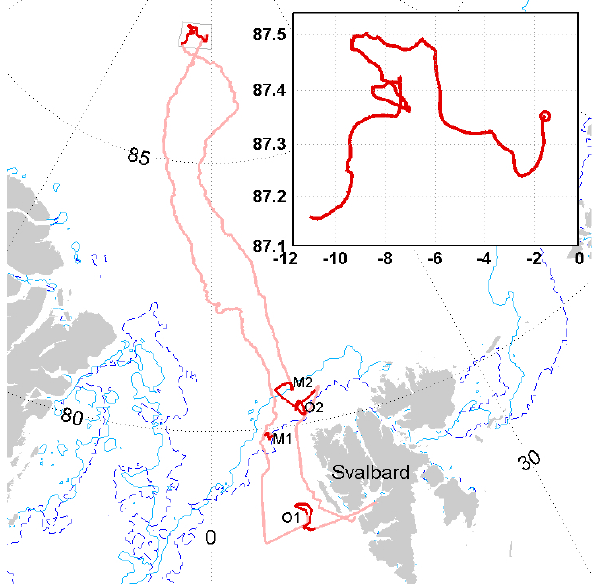
Fig. 1. Plot of the cruise track (red) also showing the track of the ice drift (inset). The left-hand part of the track shows the initial north- ward track while the right-hand track shows the southward return track. Convoluted track lines in open water (O1 and O2) and at the ice edge (M1 and M2) are associated with shorter sampling stations. The dashed blue line illustrates the ice edge at the time of entry and